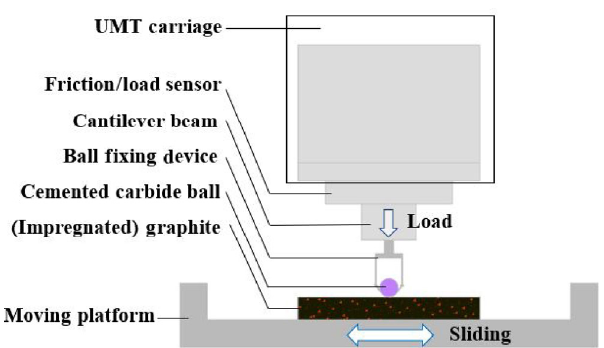
Fig. 1 Schematic illustration of sliding friction test.